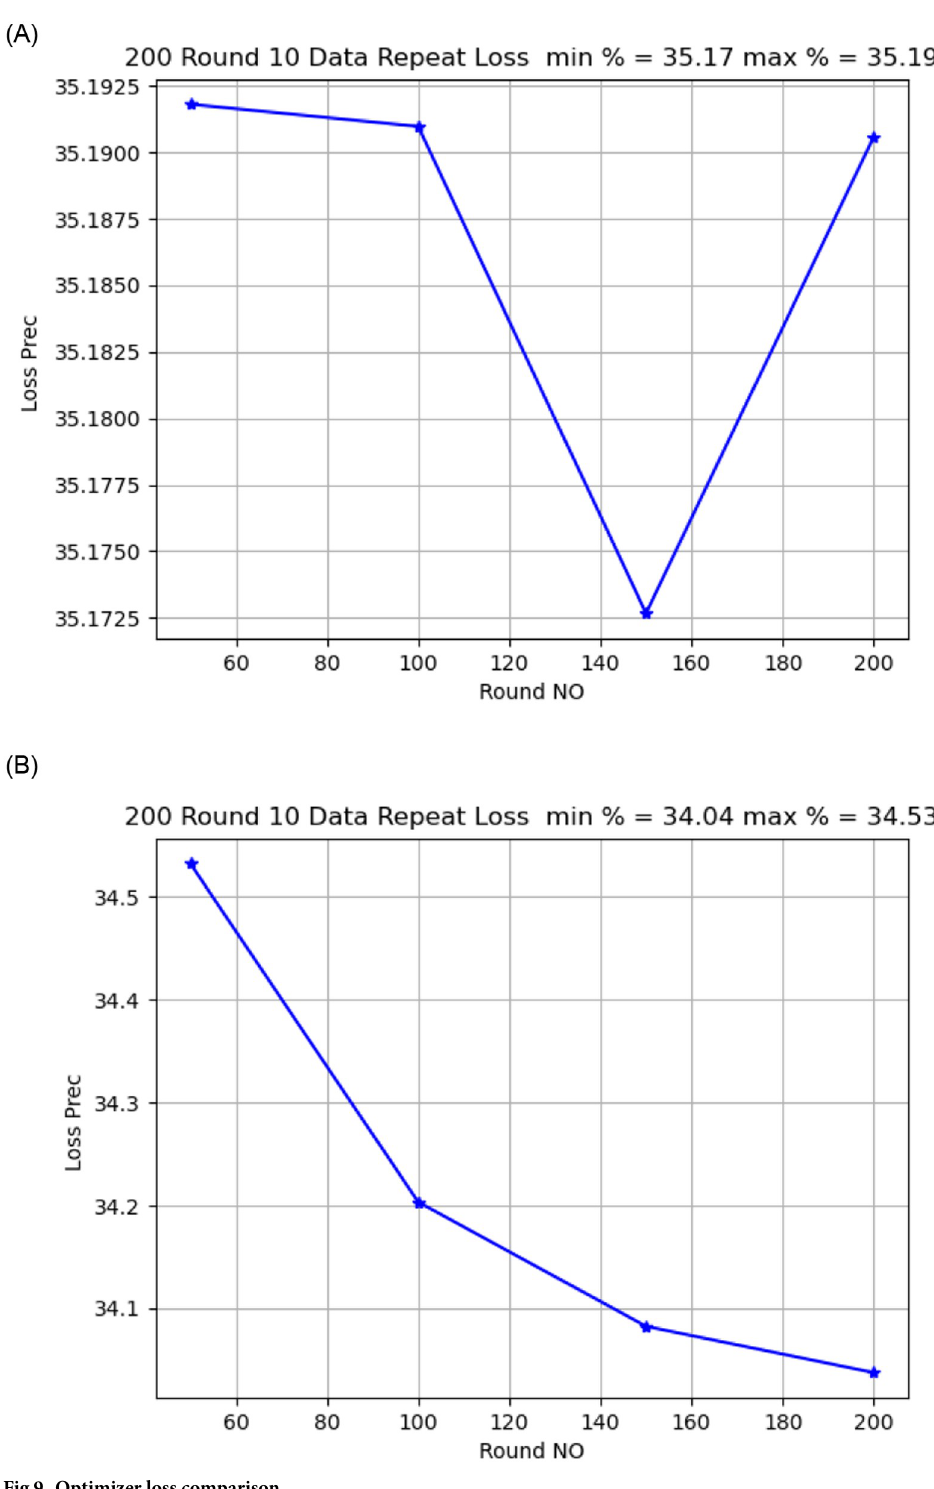
Fig 9. Optimizer loss